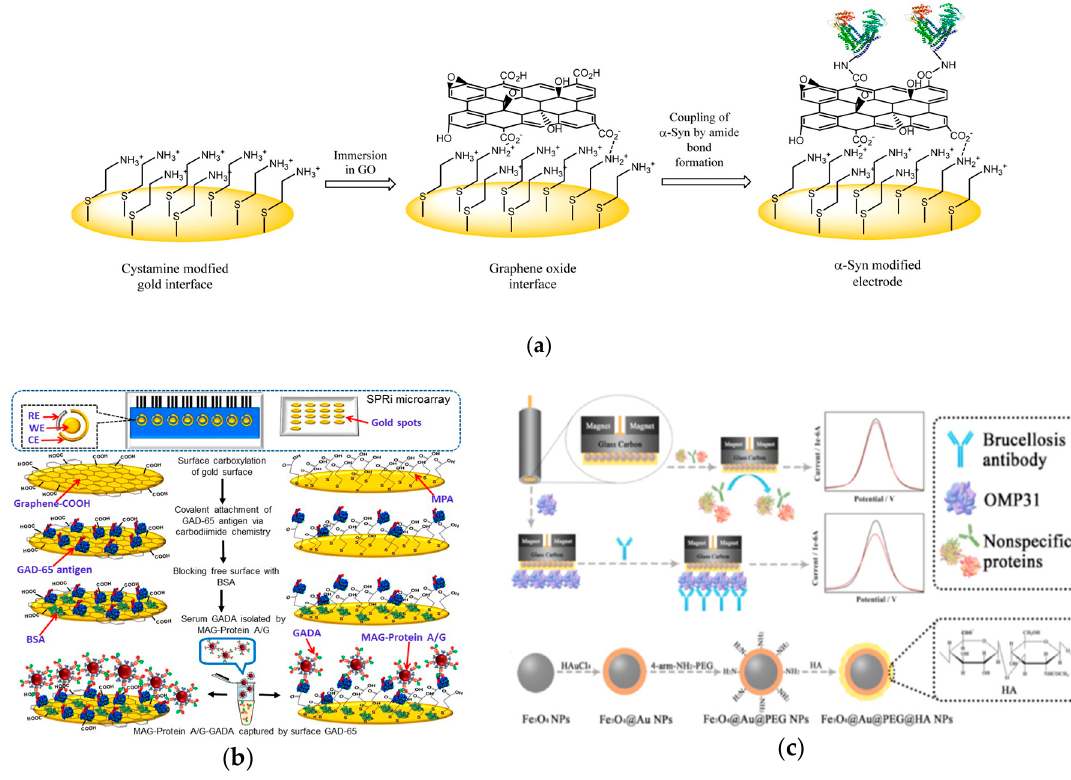
Figure 4. ( a ) Schematic illustration of the sensing platform. Cysteamine-modified gold interface is immersed in graphene oxide and then activated to form amide bonds with α -Syn antigens (Adapted with permission from Ref. [46] Copyright 2015 American Chemical Society). ( b ) Comparative analysis between graphenyl surface and mercapto-monolayer surface. (Adapted with permission from Ref. [47]. Copyright 2018 American Chemical Society.) ( c ) Top: schematic of electrochemical sensor for detection of brucellosis antibody on magnetic glassy carbon electrode. Bottom: schematic for formation of magnetic core-shell Fe3O4 nanoparticles modified with polyethylene glycol and hyaluronic acid. (Adapted from Ref. [48]. Copyright © 2018 Elsevier B.V.)